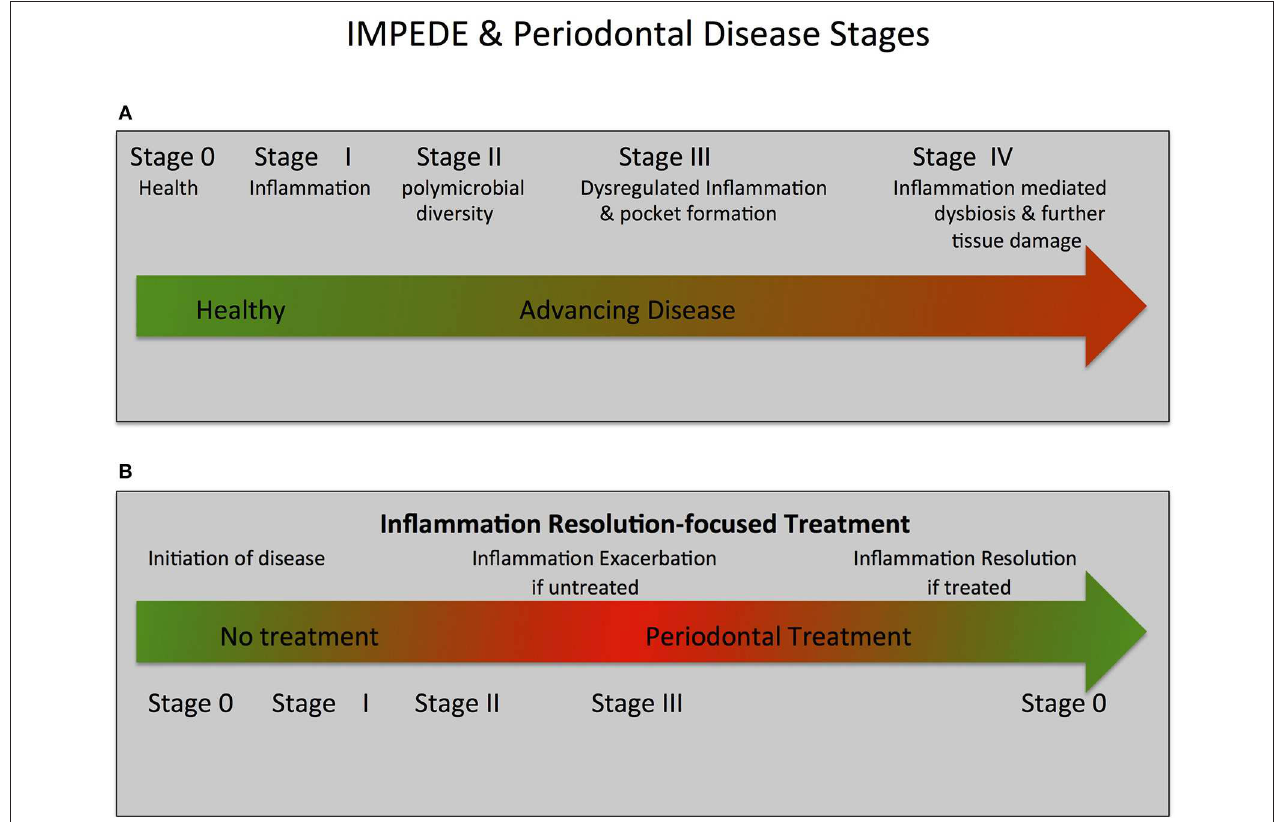
FIGURE 2 | IMPEDE, Periodontal Disease Classification Stages and Treatment.The IMPEDE model proposes that inflammation can manifest for each periodontitis classification stage as a principal driver of the clinical condition. In keeping within the framework of the current classification of periodontitis, the IMPEDE model identifies 5 stages (0–IV) integrating the transition from health, to gingivitis and (if untreated) ultimately to periodontitis. (A) IMPEDE stages within the new classification framework. 0 = Periodontal Health; Stage I = Gingivitis (initiation of inflammation); Stage II = Initiation/early periodontitis (Polymicrobial diversity emerges); Stage III = Advancing Periodontitis (dysregulated inflammation and pocket formation) and Stage IV = Late stage periodontitis (Inflammation mediated dysbiosis, opportunistic infection and advanced tissue destruction). (B) Inflammation-mediated polymicrobial dysbiosis and tissue damage can be exacerbated if no treatment is provided or can be driven toward resolution of inflammation and tissue repair/regeneration if treatment is